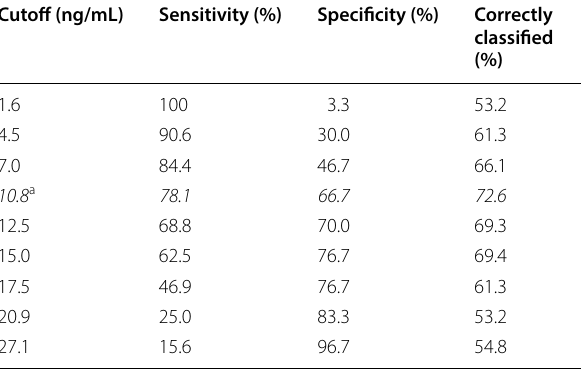
Table 3 Sensitivity and specificity for the prediction of poor outcome for different baseline GDF-15 cutoff values